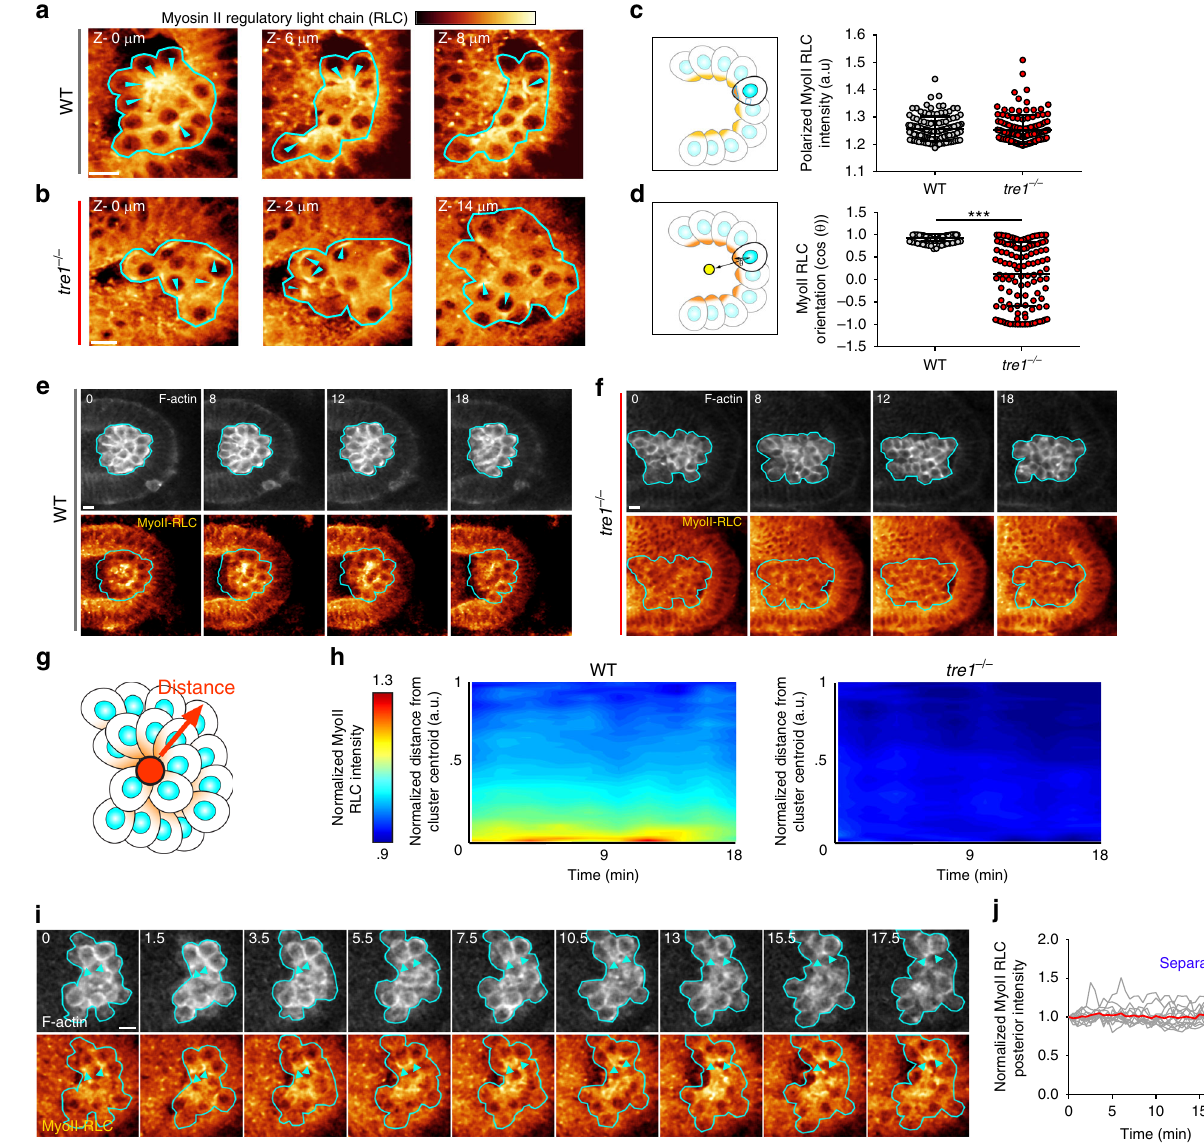
Fig. 3 Myosin II polarity is collectively oriented and remains persistent during separation. a , b Two-photon imaging of myosin II-RLC GFP in a representative WT ( a ) or tre1 − / − ( b ) cluster. Myosin II-RLC is pseudocolored with the indicated color bar on top (intensity ranges: 2319 – 4005 ( a ) and 2203 – 3803 ( b )). Different Z slices with indicated depth relative to the fi rst slice are shown. Cyan arrows indicate regions of myosin II-RLC accumulation. Representative images are from n = 15 embryos in ( a ) and n = 13 embryos in ( b ). c , d Quanti fi cation of polarized myosin II RLC intensity ( c ) and myosin II RLC orientation ( d ) in WT ( n = 123 from 15 embryos) or tre1 − / − ( n = 127 from 13 embryos) PGCs. Data are presented as mean values ± SD. Statistical comparisons are from a Mann – Whitney test in ( d ) with p < 0.0001. *** p < 0.001. Two-photon timelapse imaging of a representative WT ( e ) or tre1 − / − ( f ) PGC cluster expressing lifeact-tdTomato and myosin II RLC-GFP for 18 min prior to endoderm EMT. Myosin II-RLC is pseudocolored with the indicated color bar above ( a ) (intensity ranges: 1072 – 2171 ( e ), 3198 – 7726 ( f )). A single Z slice is shown. Representative images are from n = 6 embryos in ( e and f ). g Schematic of how intensity vs. distance from cluster centroid is calculated. h Quanti fi cation of the average myosin II RLC intensity vs. distance from the cluster centroid over time in WT ( n = 6 embryos) and tre1 − / − ( n = 6) PGC clusters. i Two photon timelapse imaging of a representative WT PGC cluster expressing lifeact-tdTomato and myosin II RLC-3xGFP over time. Myosin II-RLC is pseudocolored with the indicated color bar on top of ( a ) (intensity range: 2560 – 5624). A single Z slice is shown. Cyan arrows indicate regions of myosin II RLC accumulation from the same pair of cells. Representative images are from n = 5 embryos. j Quanti fi cation of myosin II RLC-3xGFP intensity at the posterior over time. Grey curves show single cells while the red curve indicates the mean. n = 13 PGCs from 5 embryos. All scale bars, 10 μ m. All times are in minutes. Source data in ( c , d , h and j ) are provided as a Source Data fi